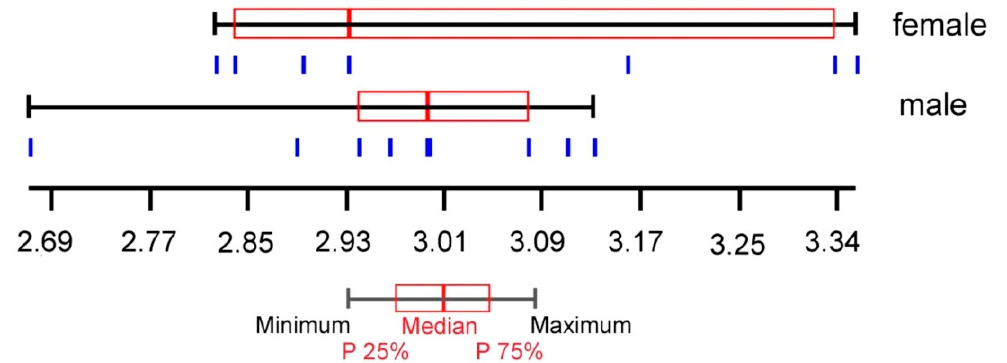
Figure 4. Centroid size variation of the wings between sexes of Haematobosca aberrans Pont, Duvallet & Changbunjong, 2020, shown as quartile boxes. Each box shows the group median separating the 25th and 75th quartiles. Vertical bars under the boxes represent the wing (units as mm).